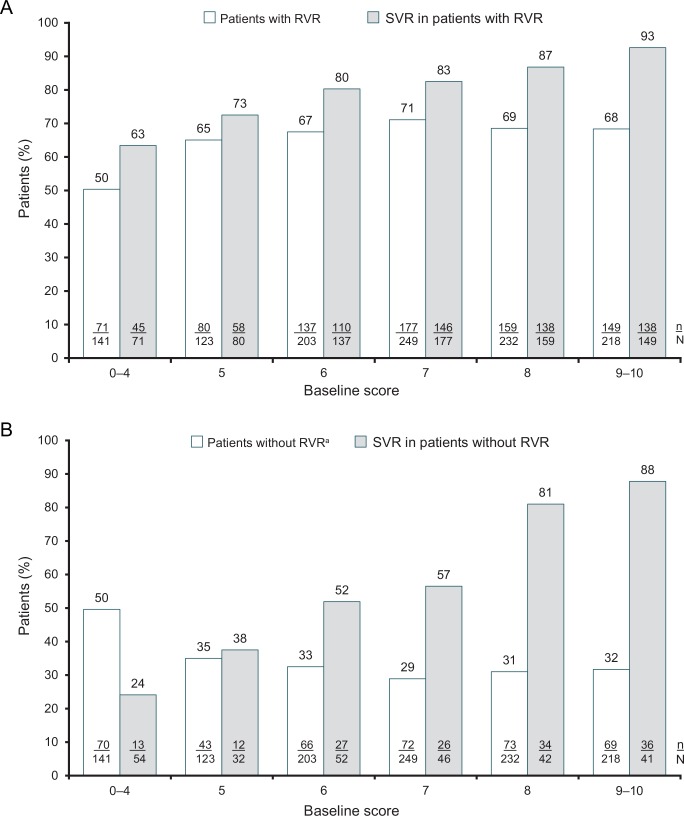
Rapid virologic response (RVR) and sustained virologic response by RVR status in patients with HCV genotype 3 by baseline score.A) Patients with an RVR; B) Patients without an RVR. RVR = rapid virologic response: HCV RNA <50 IU/mL by week 4 of treatment. a Includes patients with missing Week 4 HCV RNA results.